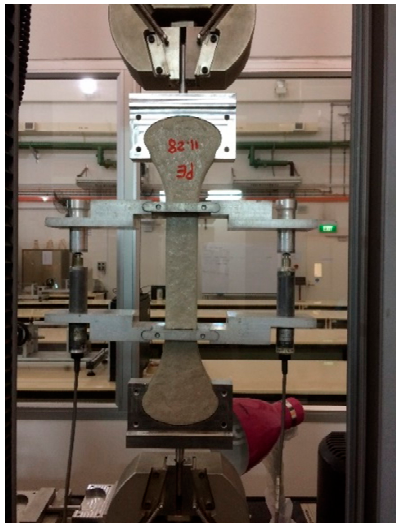
Figure 3. Test apparatus for the direct tensile test.